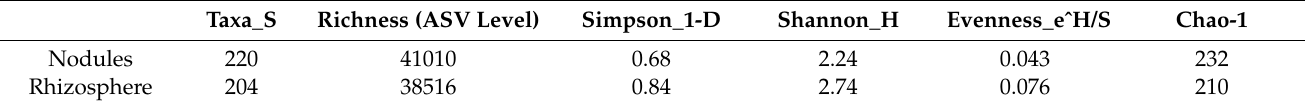
Table 2. Diversity indices generated from the results of 16S rRNA metabarcoding using PAST